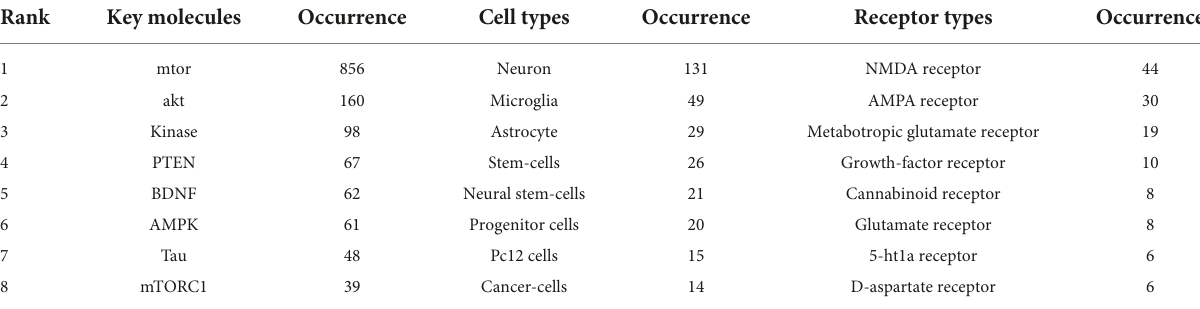
TABLE 5 Top 7 key molecules, cell types, and receptor types involved in mTOR in the nervous system.